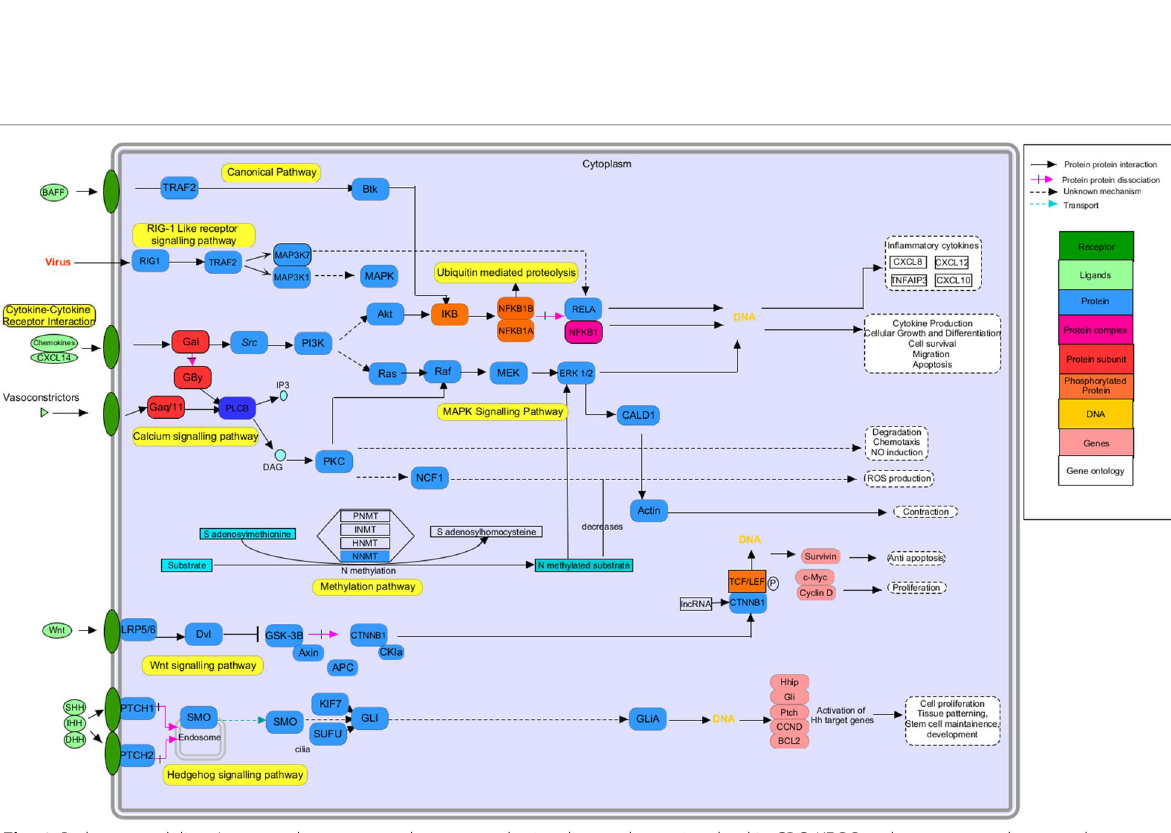
Fig. 6 Pathway modeling. Integrated genome to phenome scale signaling pathways involved in CRC. KEGG pathway was used to map the gene signatures for signaling and metabolic